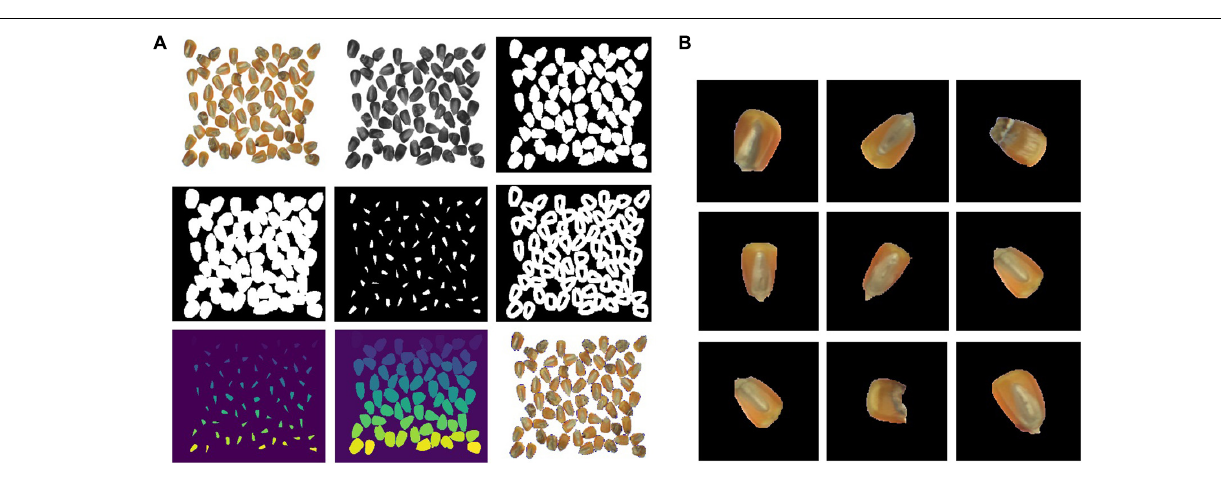
FIGURE 4 | Image processing procedures. (A) Segmentation processes and (B) segmentation